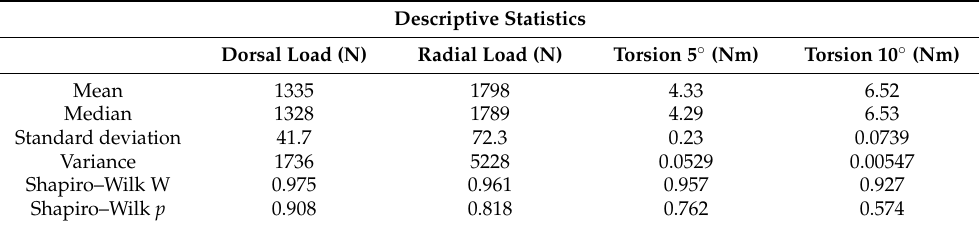
Table A1. Descriptive statistics of the intact bone models. The table contains the means, the medians, the standard deviations, the variances, and the Shapiro–Wilk W and p